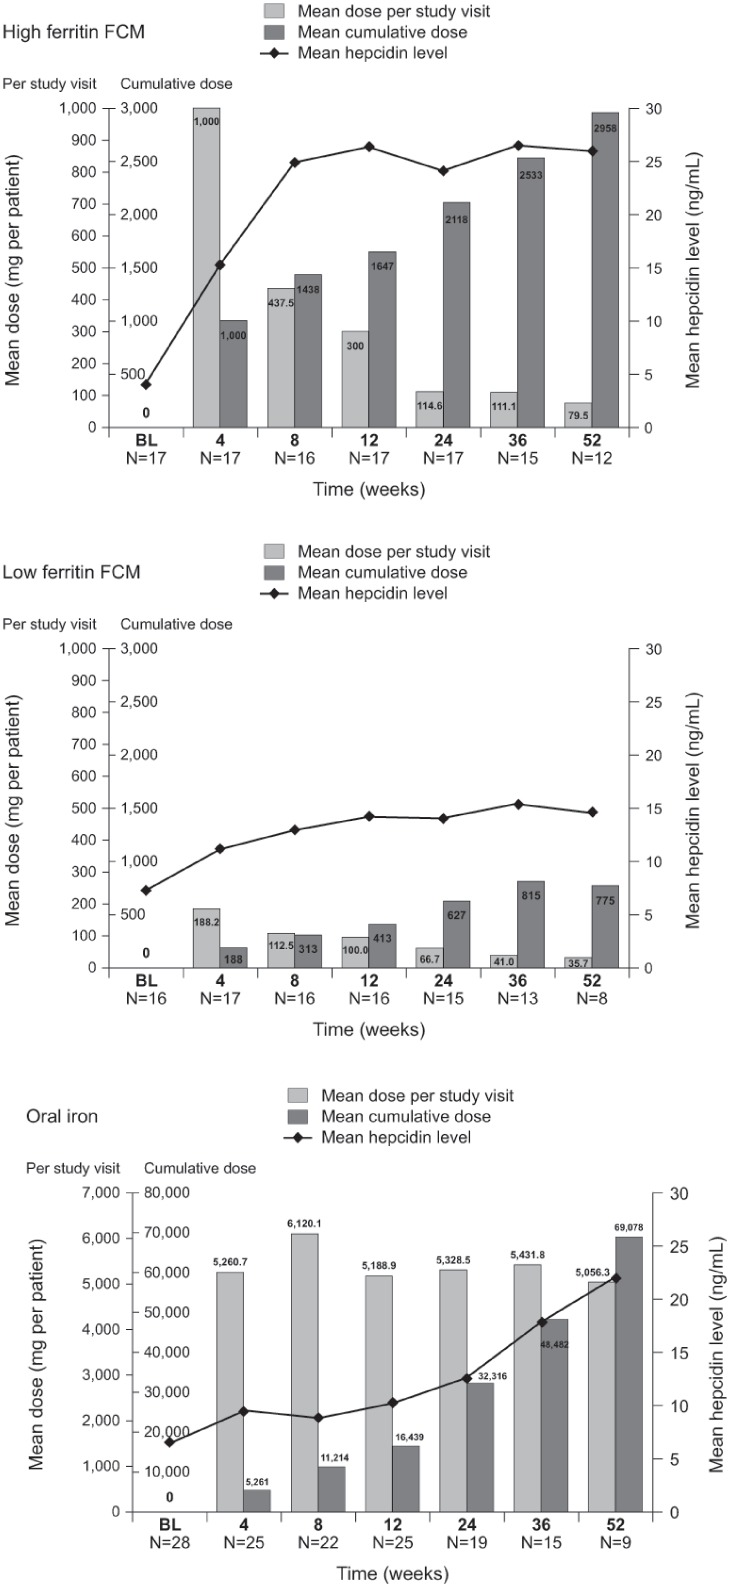
Mean hepcidin level and mean iron dose administered at each visit for (a) high ferritin FCM (b) low ferritin FCM (c) oral iron.Bars indicate iron dose per visit and cumulative iron dose, lines indicate mean hepcidin level. Only values obtained prior to the start of alternative anemia therapy are included BL, baseline; FCM, ferric carboxymaltose.